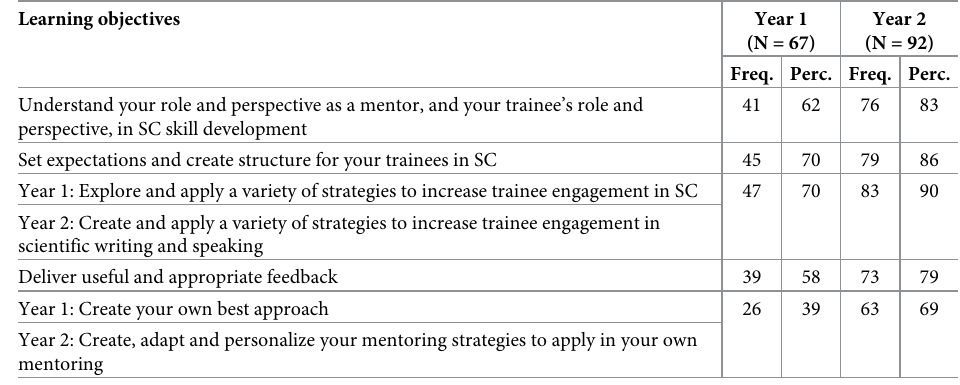
Table 4. Percentage of participants who rated the learning objectives as “definitely met”.